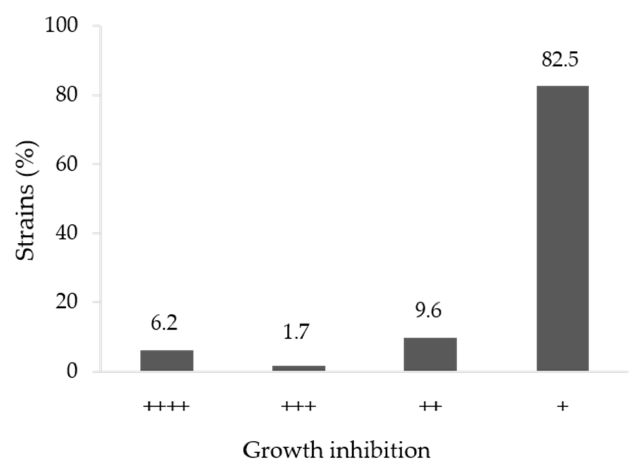
Figure 1. Percentage of bacterial strains causing different in vitro growth inhibitions of Macrophomina phaseolina TOR-102 isolate.